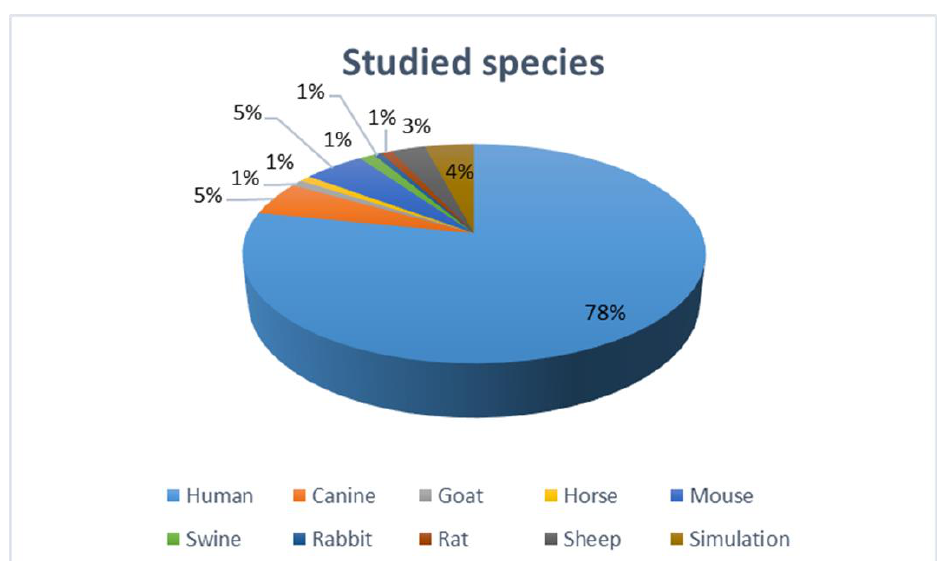
Figure 2. Literature search process.